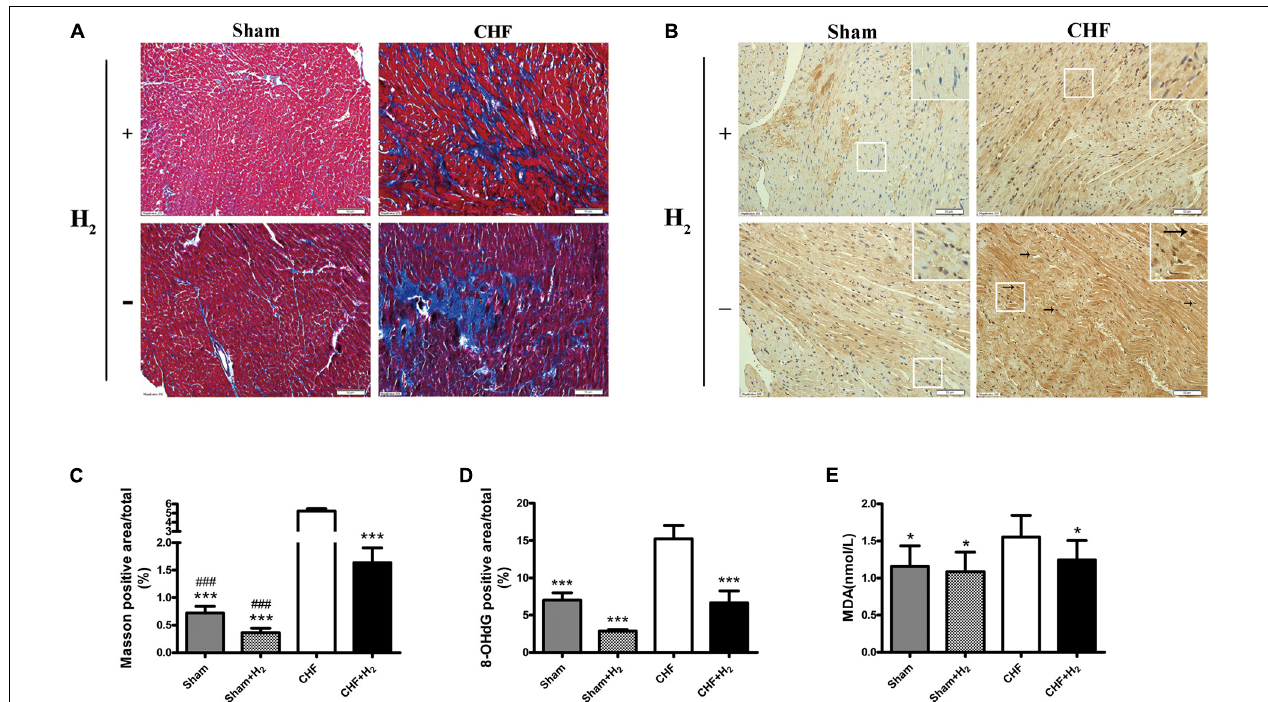
FIGURE 4 | Left ventricular remodeling size and oxidative stress damage in myocardial tissue after inhalation of H 2 and air. (A) Representative photomicrographs of Masson’s trichrome-stained heart sections are shown (magnification of 200 × ). Blue area represents fibrosis. Scale bars = 50 µ m. (B) Representative photomicrographs of immunohistochemistry about 8-OHdG (brown nuclei, arrows) are shown (magnification of 200 × ). Scale bars = 50 µ m. Inset: Magnified region illustrating 8-OHdG negative cardiomyocytes (blue nucleus) and positive ones (brown nucleus). (C) Left ventricular remodeling area was determined by measuring the area of fibrosis and was expressed as a percentage of the whole LV area ( n = 7–9). (D) 8-OHdG was determined by measuring the positive area of brown nucleus and was expressed as a percentage of the whole section area ( n = 8–10). (E) MDA levels in myocardial tissue are shown ( n = 12–14). The columns indicate the mean, and the bars indicate the SD (LVEDP, LVESP, and MDA) or SE (+dp/dt, –dp/dt, Masson, and 8-OHdG). ∗ p < 0.01 vs. CHF; ∗∗∗ p < 0.0083 vs. CHF; ### p < 0.0083 vs. CHF+H 2